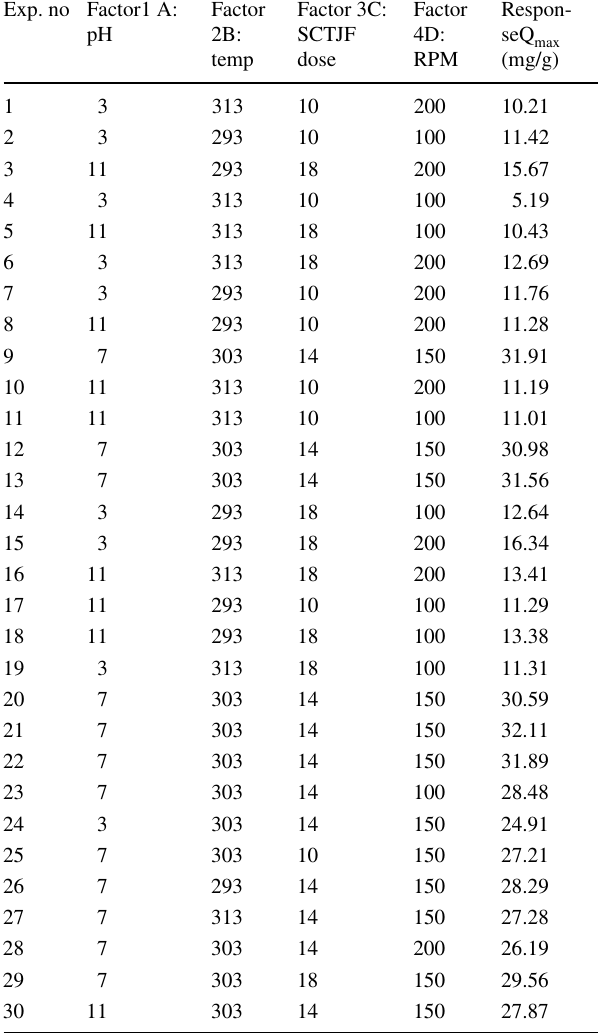
Table 6 Design layout and experimental